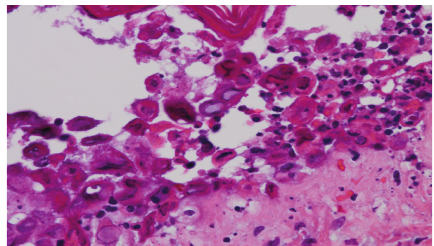
Figure 2: Case 2 demonstrating intraepidermal vesiculation with associated acantholysis and multinucleated cells characteristic of herpes simplex virus.